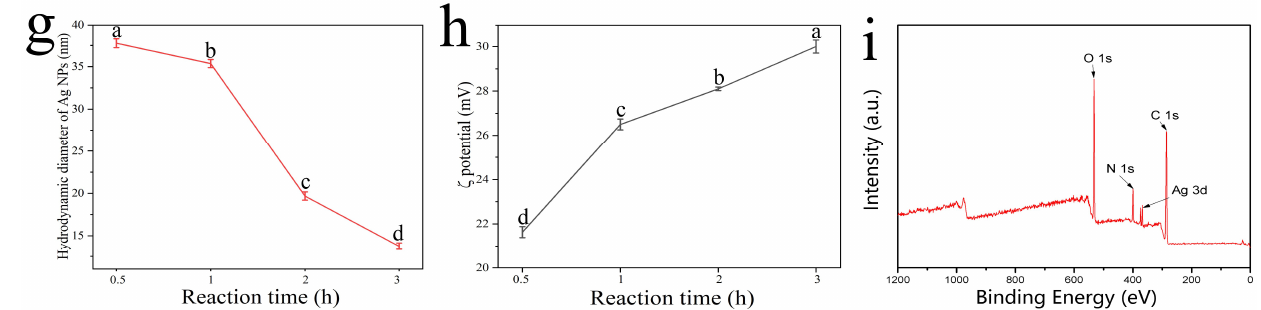
Figure 1. Digital photographs ( a ), UV–vis spectra ( b ) of Ag NPs at different reaction times; TEM image and particle size histogram of Ag NPs at different reaction times: ( c ) 0.5 h, ( d ) 1 h, ( e ) 2 h, and ( f ) 3 h (scale bar = 20 nm); hydrodynamic diameter ( g ) and zeta potential ( h ) of Ag NPs at different reaction times, vertical bars represent standard deviation of the mean (n = 6), significance was considered at p < 0.05; ( i ) XPS survey scan of Ag NPs reacted for 3 h.